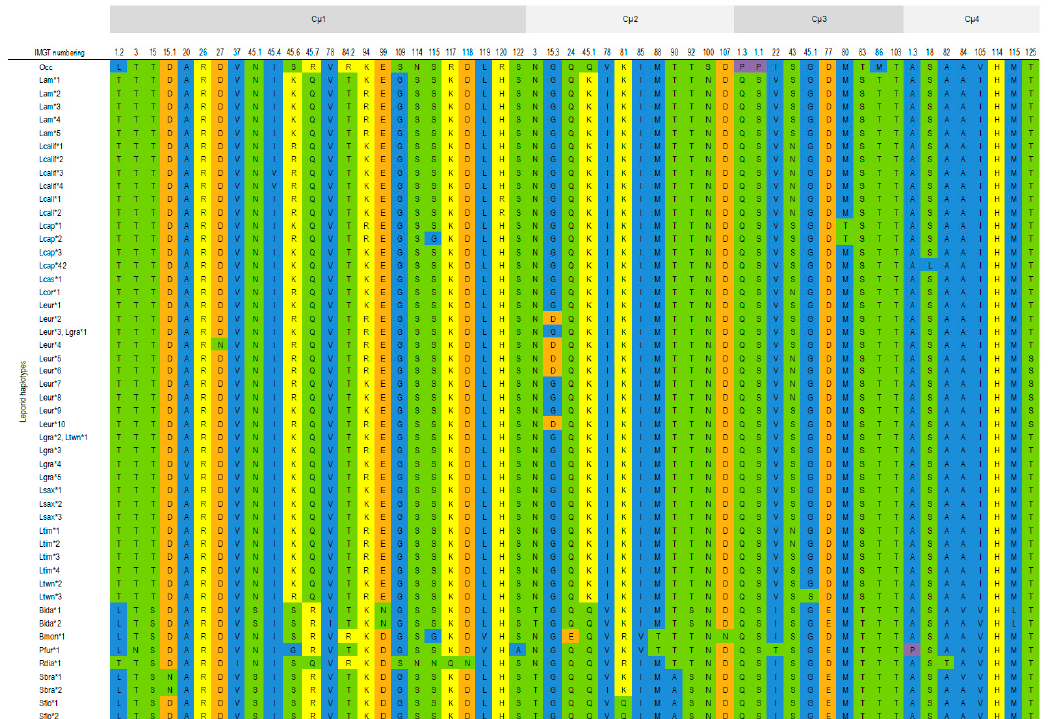
Figure 3. Variable codons and amino acid physicochemical properties for leporid IGHM constant domains. The codon numbering is according to the IMGT unique numbering for the constant domain (13). The colours represent amino acid properties: polar neutral (green), polar positive (yellow), polar negative (orange), non-polar neutral (purple), non-polar aliphatic (blue) and non-polar aromatic (light pink). Occ— Oryctolagus cuniculus cuniculus (accession number J00666); Lcalif— Lepus californicus